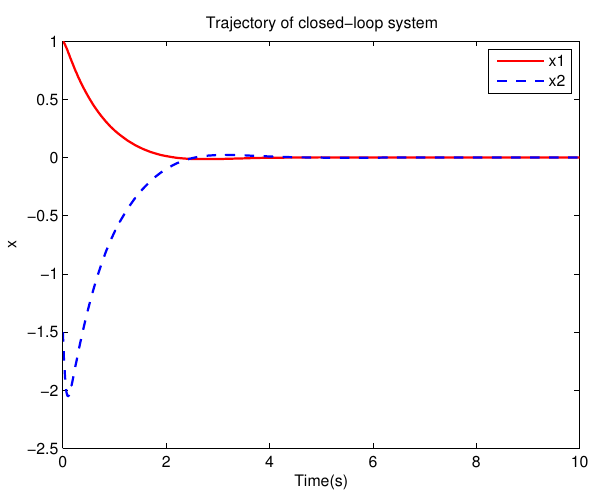
Figure 17. Closed loop system trajectory, p 1 = 1, p 2 = 2.